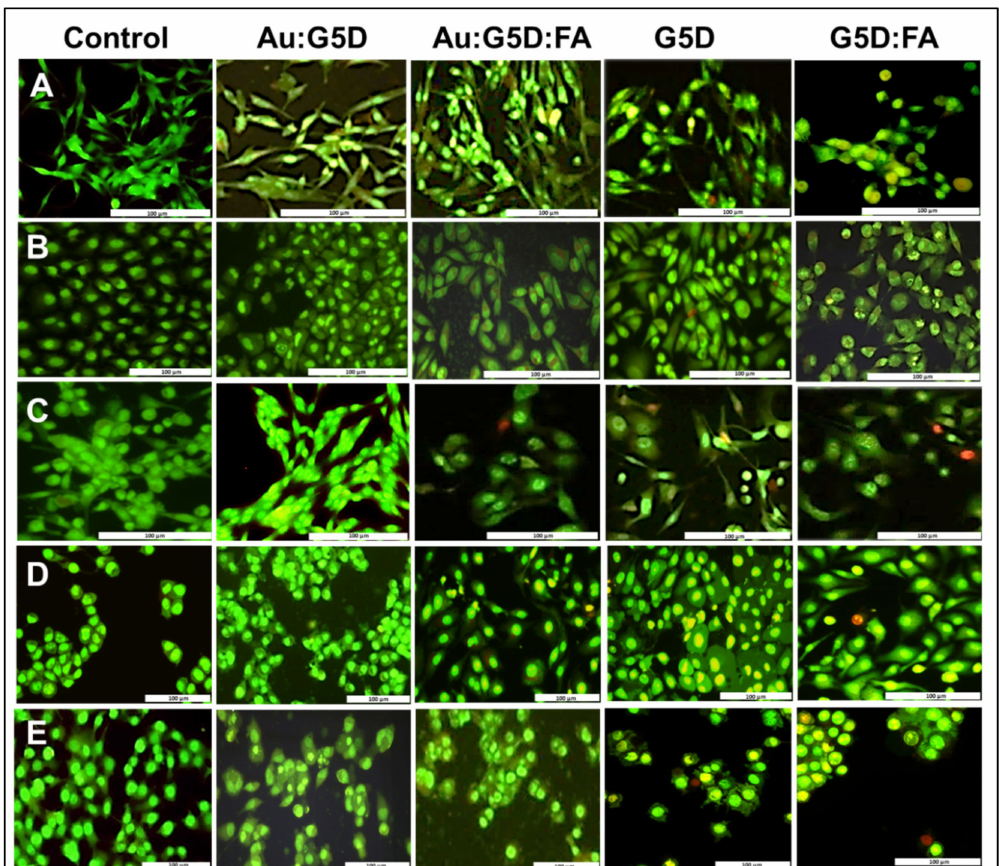
Figure 8. Fluorescence images of ( A ) HEK293, ( B ) HepG2, (C) Caco-2, ( D ) MCF-7, and ( E ) KB cells treated with test and control nanocomplexes prepared at sub-optimum ratios for 24 h, showing induction of apoptosis. Green = live (L), light orange = early apoptotic (EA), and dark orange = late apoptotic (LA) cells. Scale = 100 µ